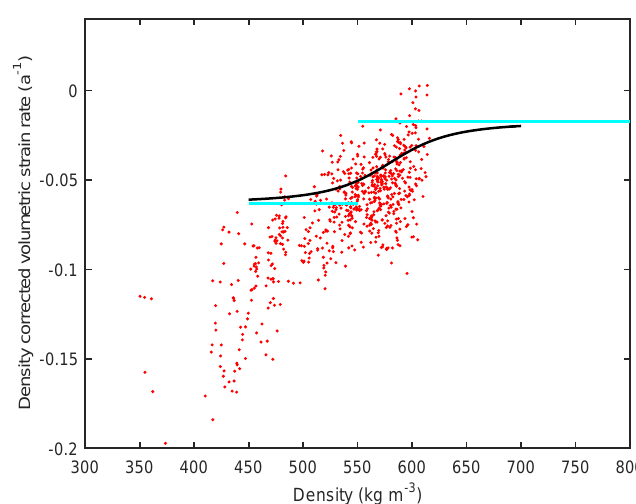
Figure 5. Measured values of F as a function of density for iSTAR Site 21 (red dots), values of c for Stage 1 and Stage 2 from the Herron and Langway model (cyan lines), and c as a function of density from the transition model with ρ T = 580 kg m − 3 , M = 7 (black line).